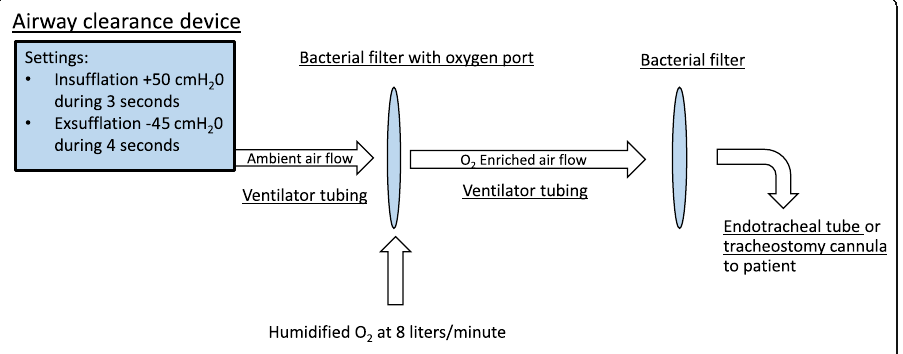
Fig. 1 Schematic of the setup of the mechanical insufflation-exsufflation